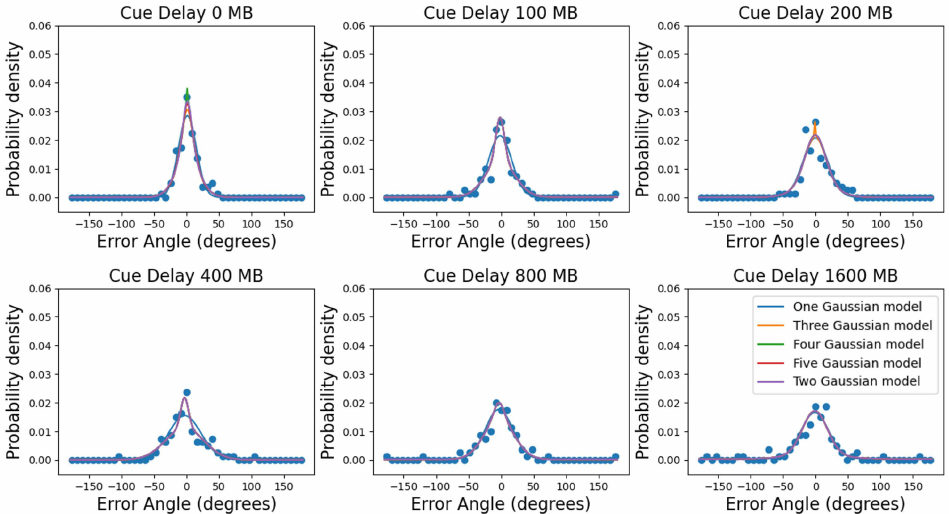
Figure 7. Multiple Gaussian model fitting results. The probability density is plotted as a function of the error angle. Figures show the data of subject MB for different cue delays for the single report condition in Experiment 2. The dots are data with a bin size of 4°. The solid curves are probability density functions that were replotted from the cumulative distribution fitting. The different color solid lines correspond to different mixture models,